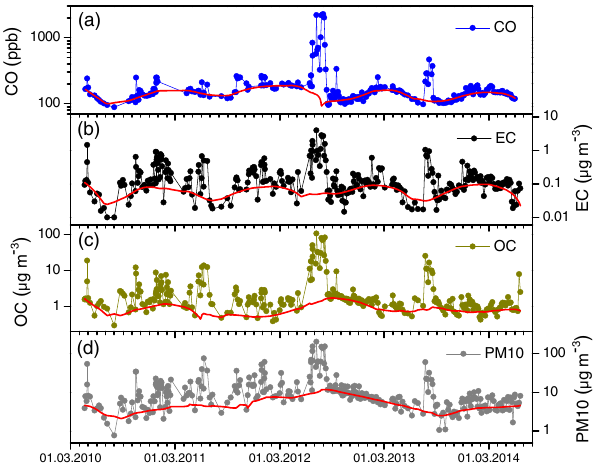
Figure 2. Time series of CO (a) , EC (b) , OC (c) , and PM 10 (d) con- centrations at ZOTTO and respective background concentrations (red solid line) as identified by the REBS algorithm (Ruckstuhl at al., 2012).